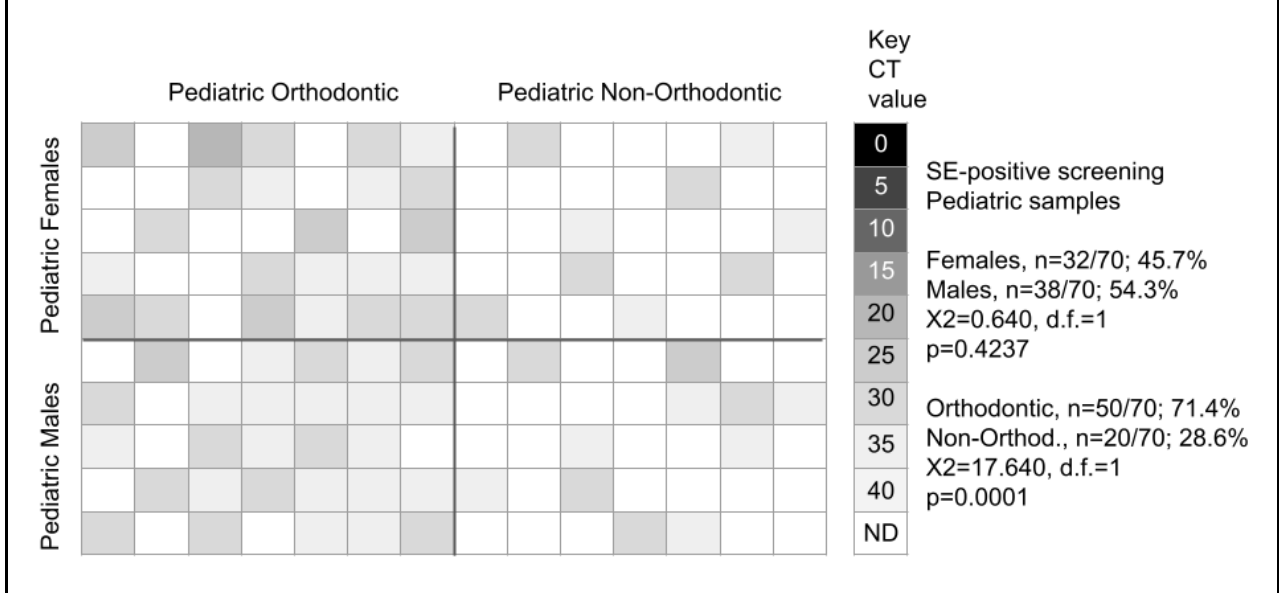
Figure 1. qPCR screening of pediatric samples for Slackia exigua (SE). Screening revealed n = 70/141 (49.6%) harbored Slackia exigua (SE), which was nearly equally divided among females (45.7%) and males (54.3%), p = 0.4237. The majority of Slackia exigua (SE)-positive samples were found among orthodontic patients (71.4%) versus non-orthodontic samples (28.6%), p =